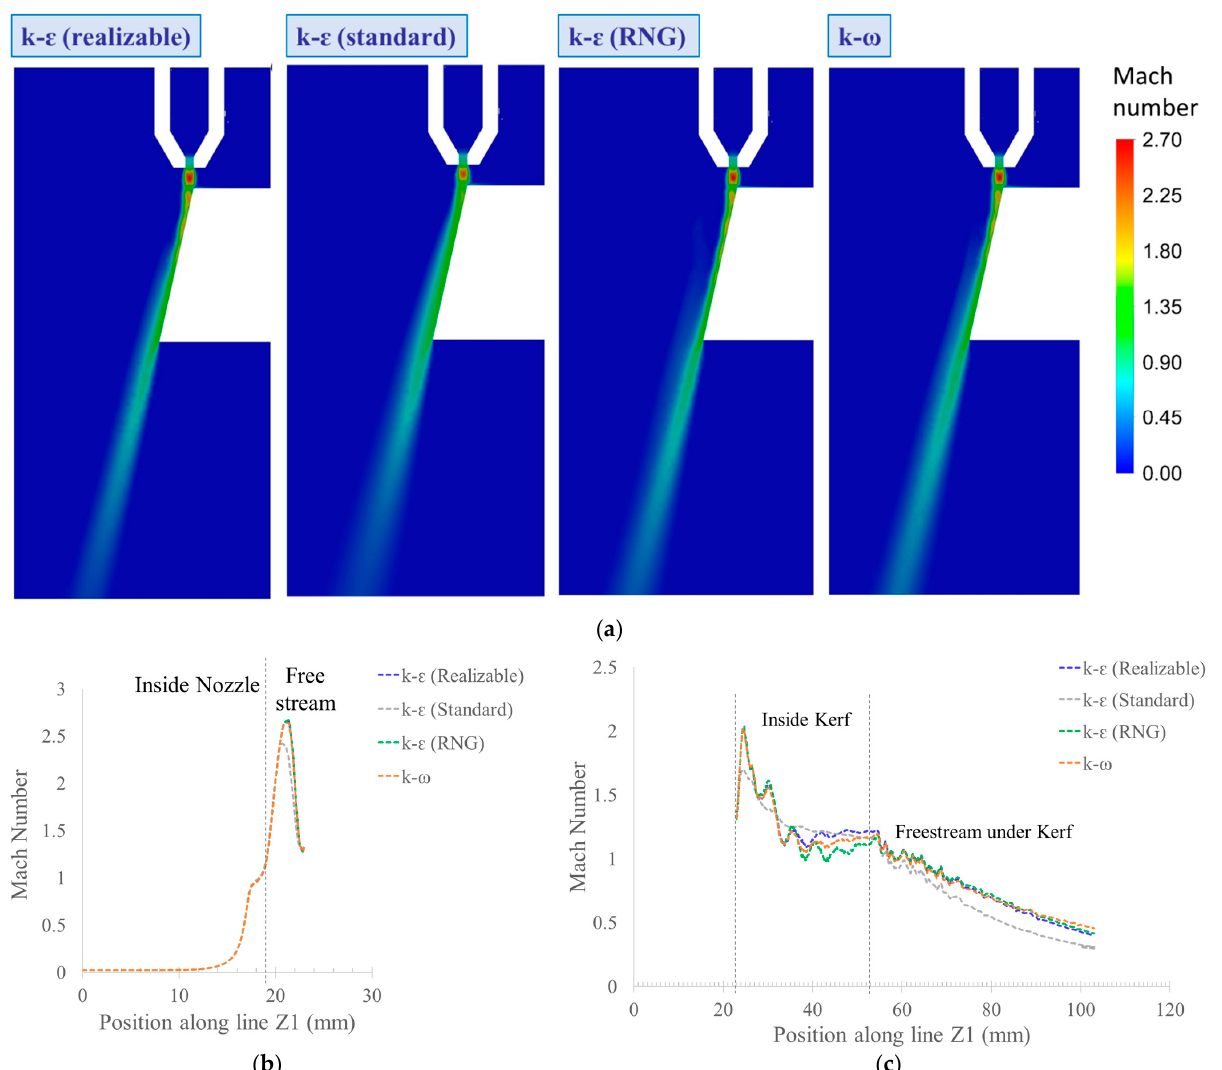
Figure 9. Mach number distribution. ( a ) Numerical simulation results for Mach number distribution along the symmetry plane for four turbulent models. ( b ) Mach number distribution curve along the line Z1 for four turbulent models. ( c ) Mach number distribution curve along line Z2 for four turbulent models.